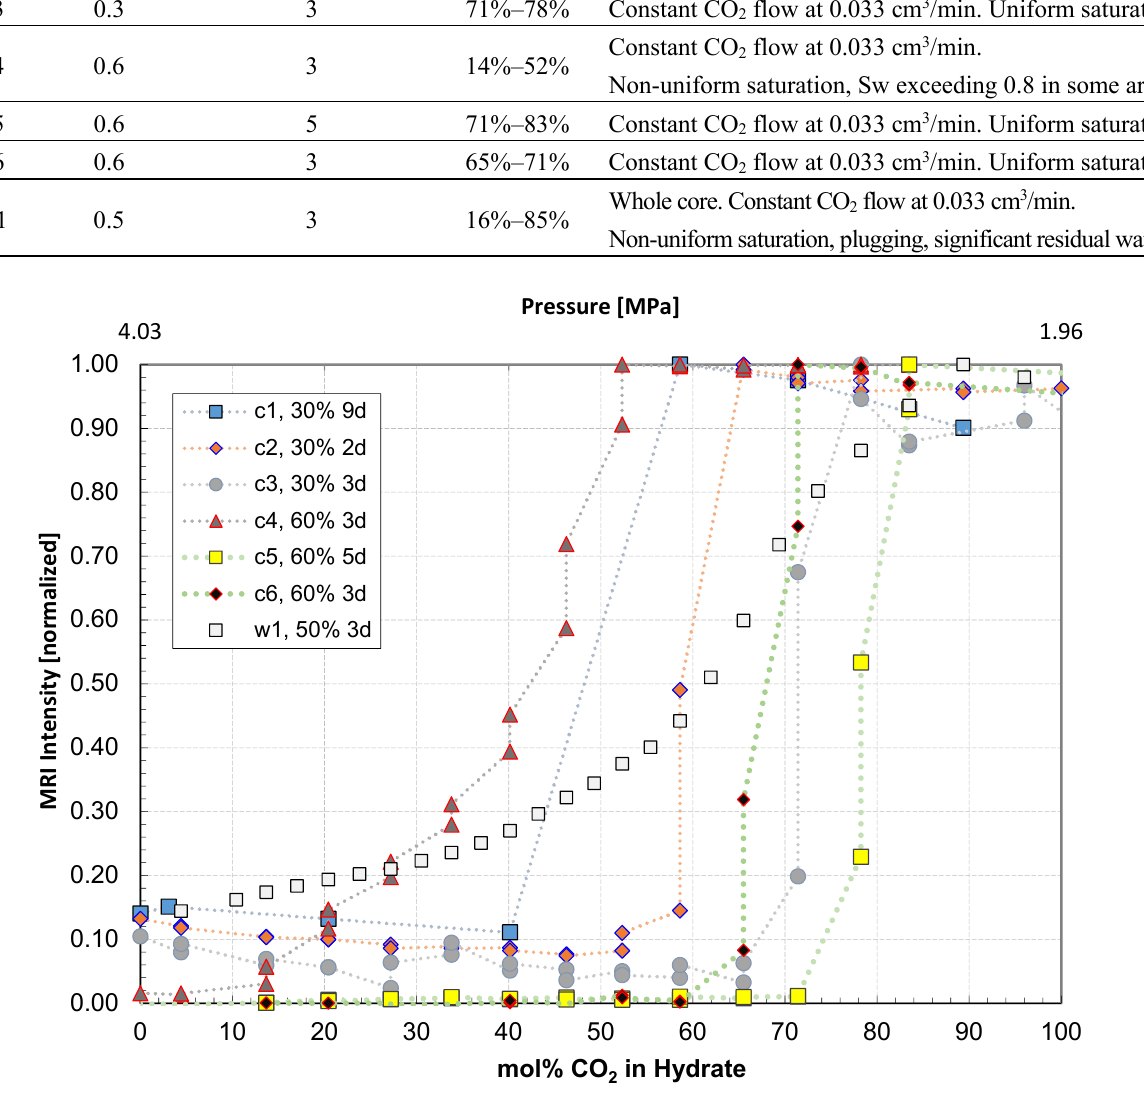
Figure 9. Comparison of overall exchange efficiency for different approaches during CO 2 exchange (c: cycle, w: whole core, i.e. , c1 is cycle 1, S w = 0.3, 9 days exposure